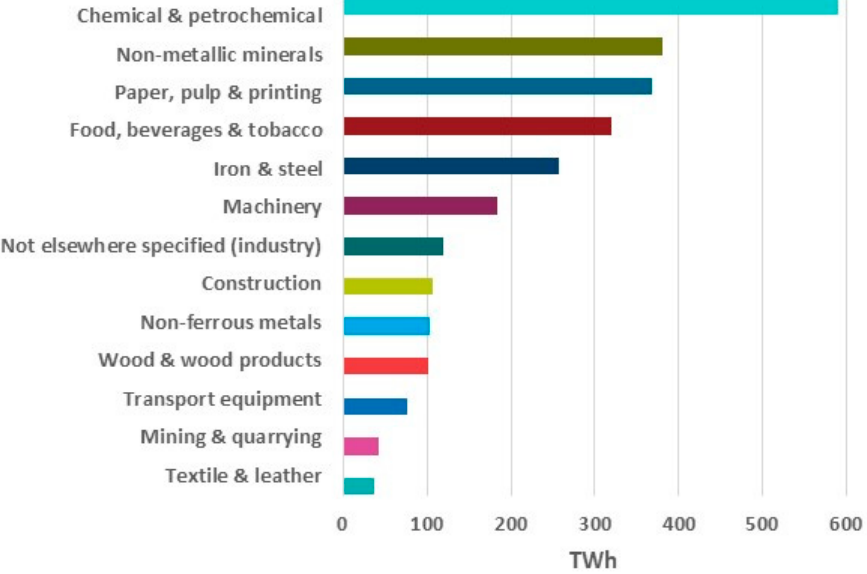
Figure 1. European energy consumption in 2020 by industrial sector. Plotted from information in the Eurostat database [4].